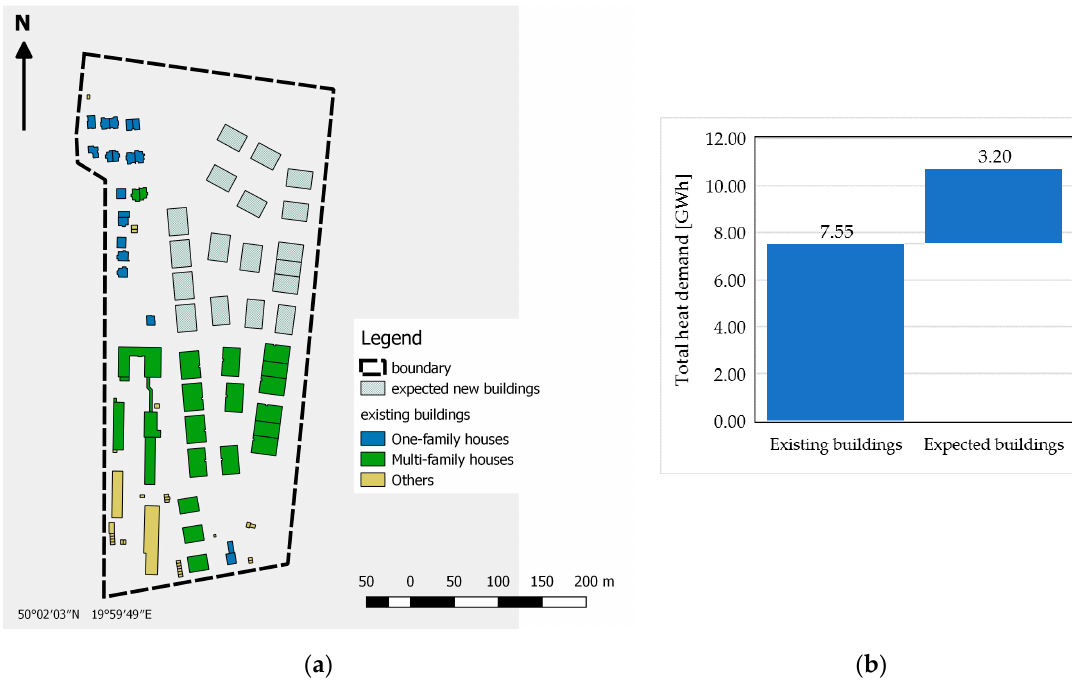
Figure 7. ( a ) The boundary for demonstrating short-term demand projection; ( b ) The additional heat demand from the expected buildings in this area.